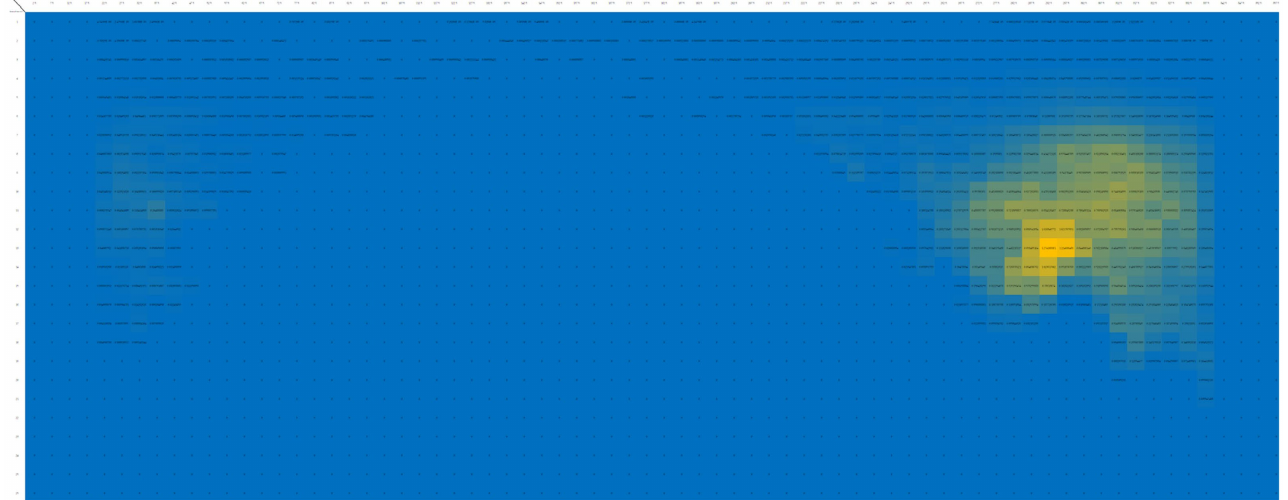
Figure 17. Thrust force matrix under ballast condition on target route in